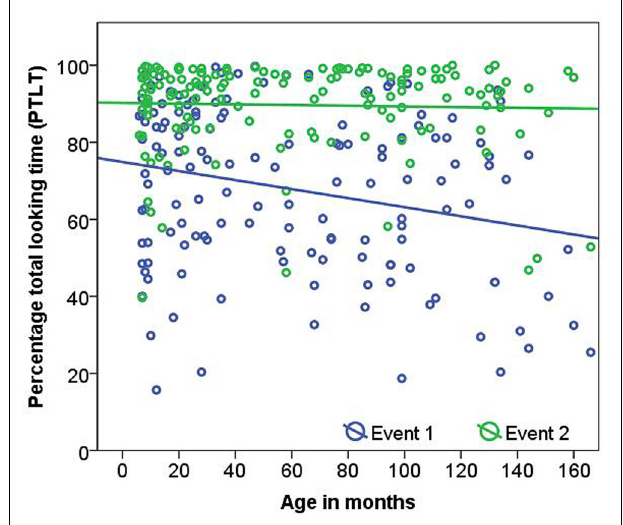
FIGURE 3 |Age related changes in percentage total looking time (PTLT) to Event 1 and Event 2